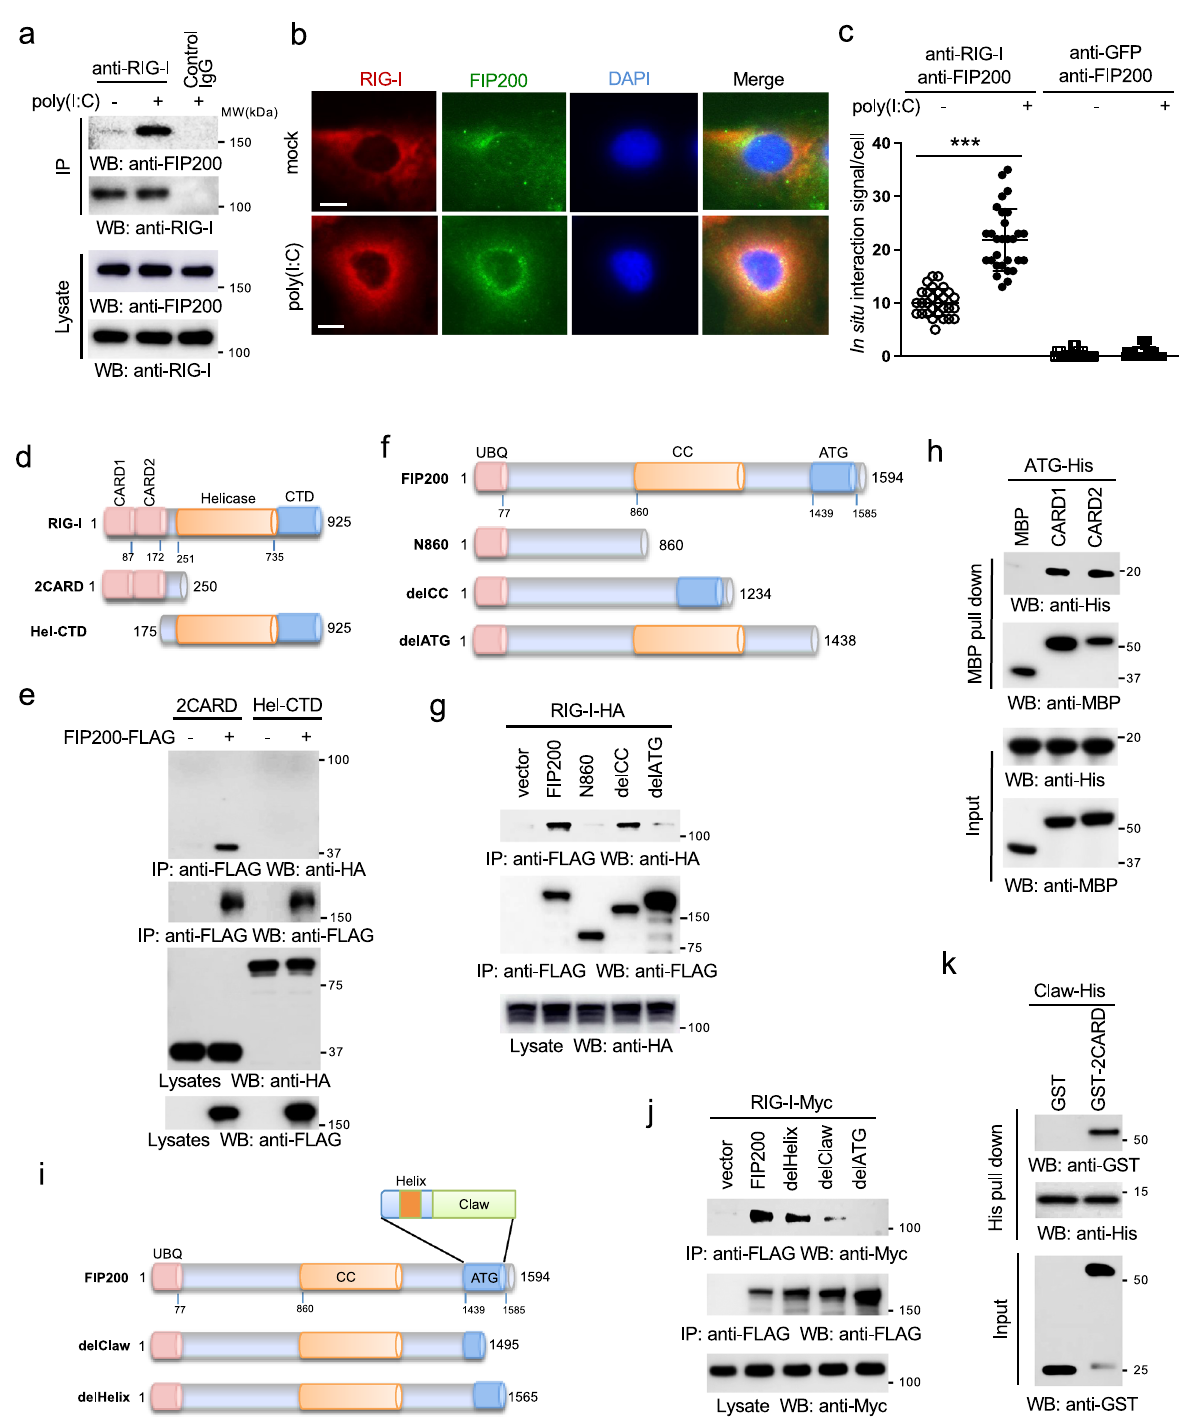
domain contains two smaller distinct domains, an alpha-helix and a claw shape structure (Claw) (Fig. 1i) 23 . Deletion of Claw, but not helix, reduced the binding of FIP200 to RIG-I (Fig. 1j). In vitro pull-down further found the direct interaction between the 2CARD and the Claw domain (Fig. 1k). The combined data suggest that Claw domain and CARD domain mediate the interaction between FIP200 and RIG-I. Ectopic expression of FIP200 promotes RIG-I activation . The interaction between FIP200 and RIG-I suggests a potential link